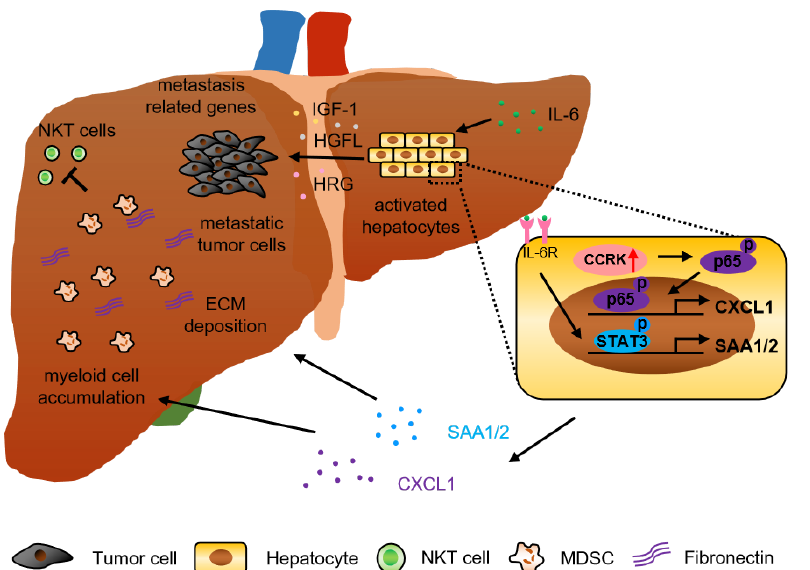
Figure 1. Hepatocyte-derived factors drive pre-metastatic niche formation for cancer metastasis. Schematic diagram showing the effects of hepatocyte-derived factors on establishment of